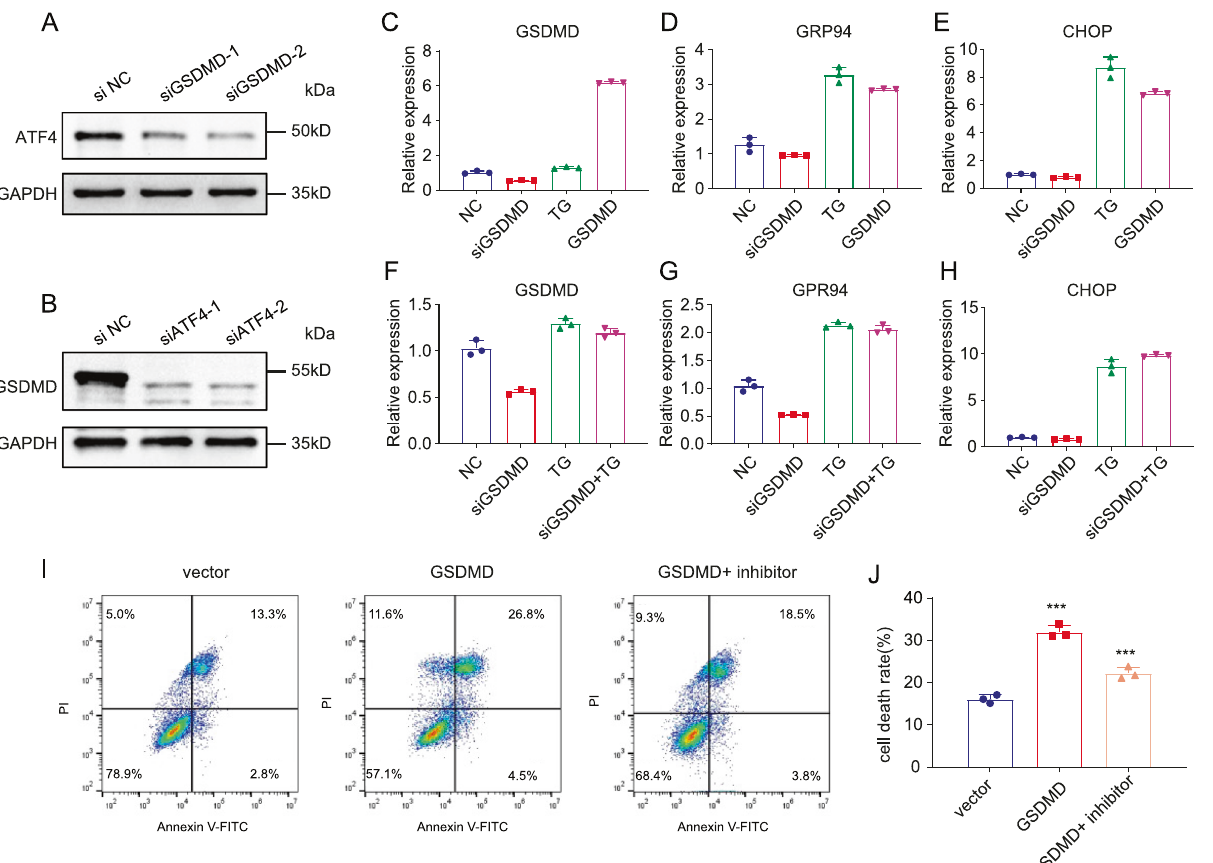
Fig. 5 GSDMD increases eIF2 α phosphorylation and activates many downstream ER stresses. A Western blot showing the expression of GSDMD when knocking down ATF-4. B Western blot showing the expression of ATF4 when knocking down GSDMD. C – E After GSDMD siRNA, TG or GSDMD-overexpression treatment, qPCR was used to detect the change of mRNA level of GSDMD ( C ), ER-stress downstream genes GRP94 ( D ) and CHOP ( E ) in Cal-27 cells. F – H After GSDMD siRNA, TG or TG + siRNA treatment, qPCR was used to detect the change of mRNA level of GSDMD ( F ), ER-stress downstream genes GRP94 ( G ) and CHOP ( H ) in Cal-27 GSDMD stable overexpression cells. ( I ) Flow cytometry to detect cell death after treatment with cisplatin (48 h), in control cells, GSDMD-overexpression cells and GSDMD-overexpression cells